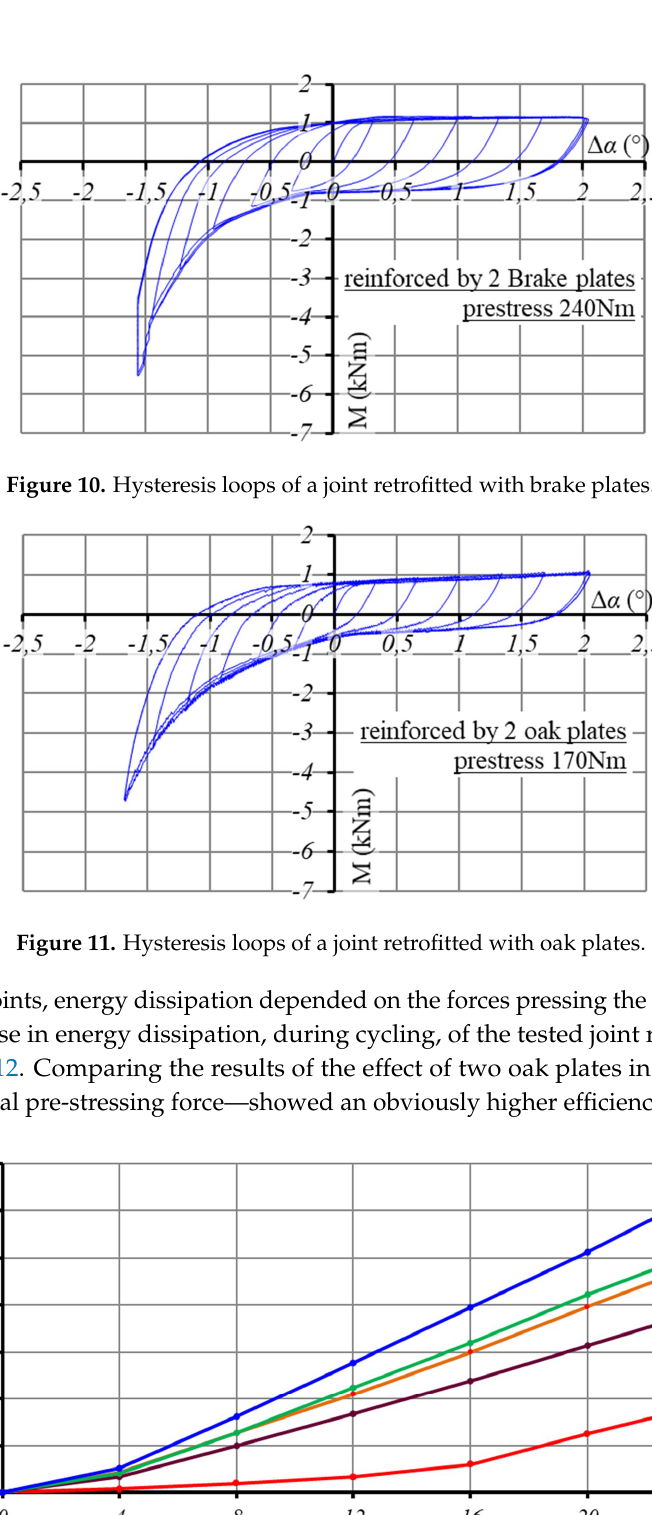
Figure 9. Hysteresis loops of a typical imperfect halved dovetail joint before retrofitting.